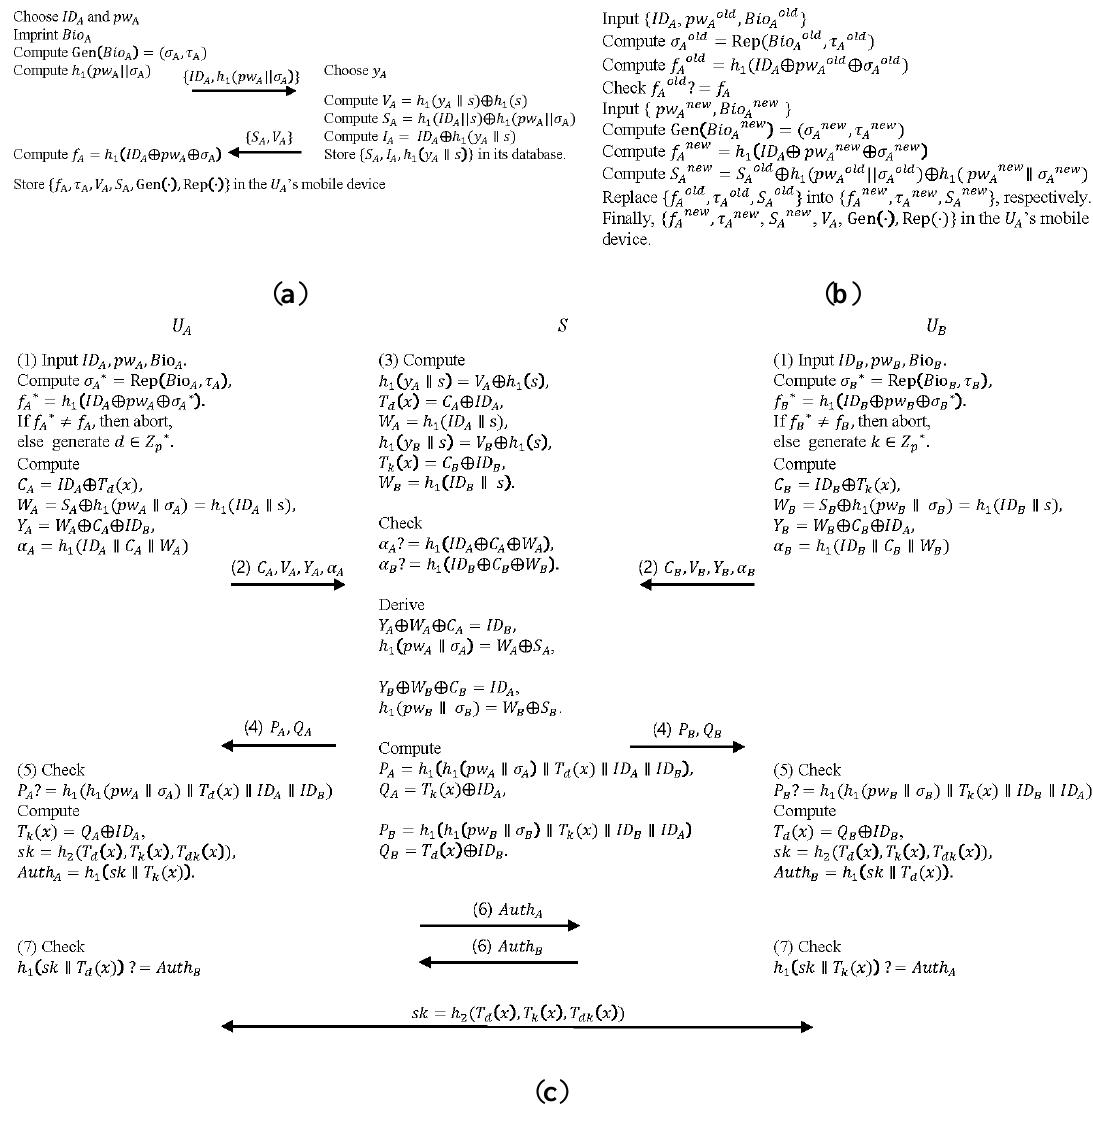
Figure 2. ( a ) Registration phase; ( b ) Password and biometric update; ( c ) Login and authentication phase of SBAKE protocol.